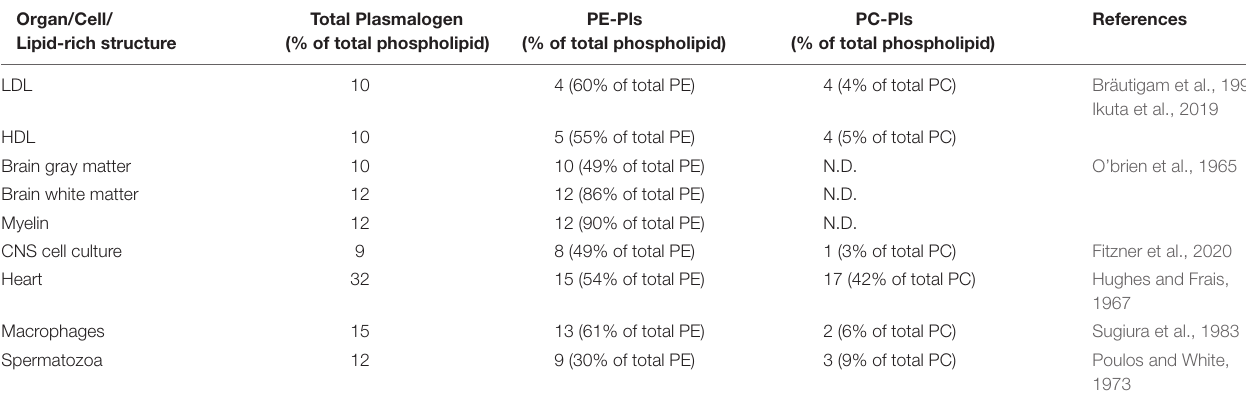
TABLE 1 | Variation of plasmalogen content among different mammalian organs/structures. Organ/Cell/ Lipid-rich structure